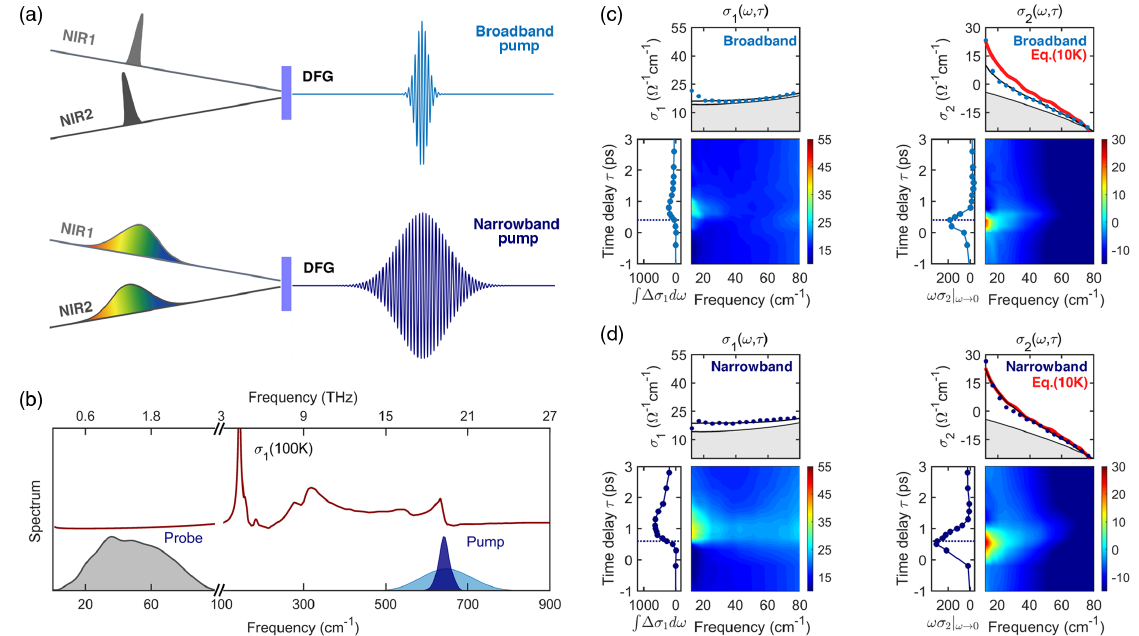
FIG. 2. Transient c -axis optical conductivity induced by apical oxygen excitation above T C . (a) Schematics of the generation processes for broadband and narrow-band excitation pulses. The signal outputs (NIR1 and NIR2) of two parallel optical parametric amplifiers were directly sent to a nonlinear crystal to generate broadband pump pulses (relative bandwidth Δ ν = ν ∼ 20 %) in a difference frequency generation (DFG) process. For narrow-band generation ( Δ ν = ν < 10 %), the two signal outputs were linearly chirped before the DFG process (see Supplemental Material [20] for further details). (b) Equilibrium c -axis optical conductivity σ 1 ð ω Þ of YB 2 Cu 3 O 6 ( T > T C , red solid line), along with the frequency spectra of the terahertz probe (gray), broadband pump (light blue), and 19.2-THz narrowband pump (dark blue) pulses. (c) Color plots: Frequency- and time-delay-dependent complex optical conductivity measured after broadband excitation at T ¼ 100 K. Upper: Corresponding σ 1 ð ω Þ and σ 2 ð ω Þ line cuts displayed at equilibrium (gray lines) and at the peak of the coherent response ( τ ≃ 0 . 5 ps time delay, blue circles). Black lines are fits to the transient spectra with a model describing the response of a Josephson plasma (see Supplemental Material [20] for details on the fitting procedure). For comparison, we also report the equilibrium σ 2 ð ω Þ measured in the superconducting state at T ¼ 10 K (red line). Side: Frequency-integrated dissipative R ð ω Þ d ω ] and coherent [ ωσ ð ω Þj Δ σ [ 1 2 ω → 0 ] responses, as a function of the pump-probe time delay. The delay corresponding to the spectra reported in the top ( τ ≃ 0 . 5 ps) is indicated by a dashed line. (d) The same quantities as in (c), measured for narrow-band excitation at 19.2